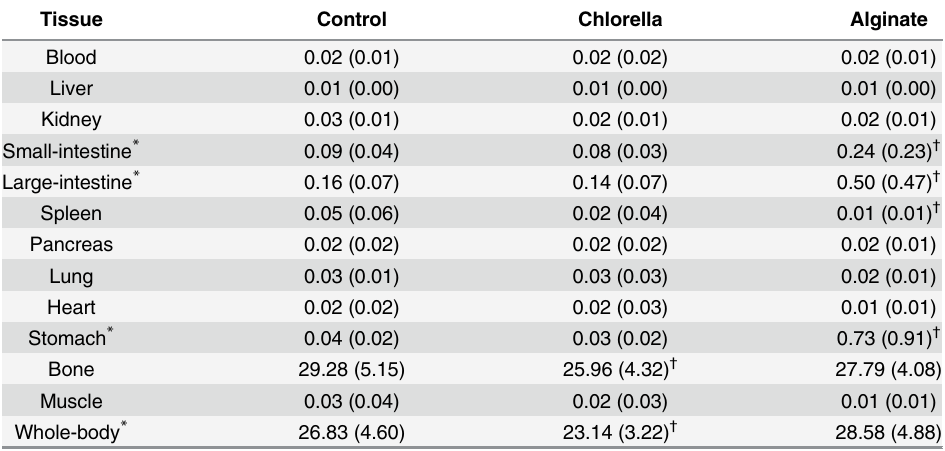
Expressed as % injected dose per gram. Each value represents the mean (SD) for twenty-eight (control), nineteen ( Chlorella ), or fourteen (alginate) animals. * Expressed as % injected dose. † p < 0.05 vs.